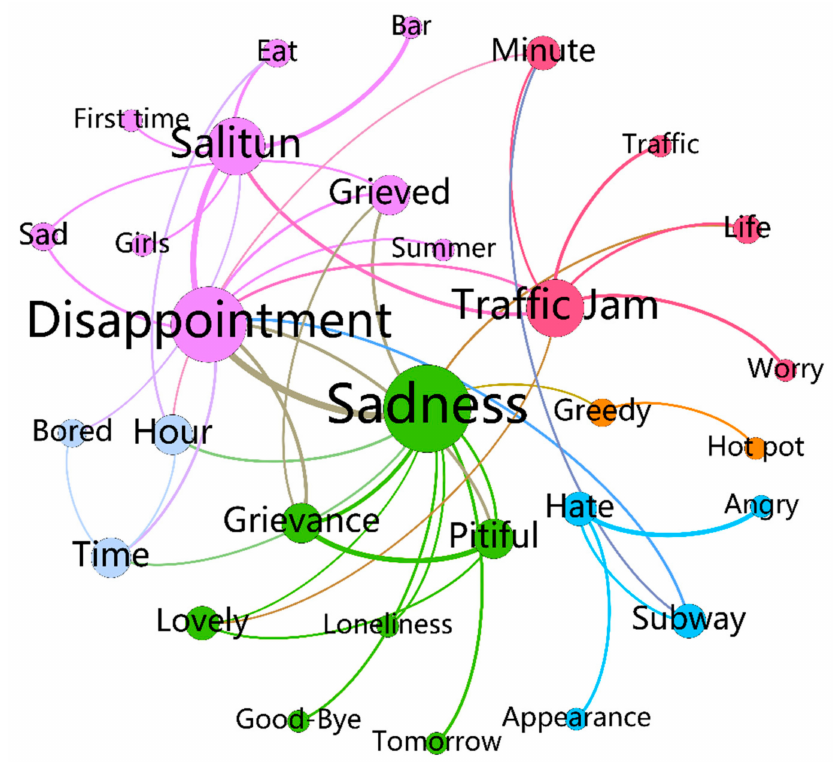
Figure A3. The negative sentiment profile of tourist flows within Area A in the